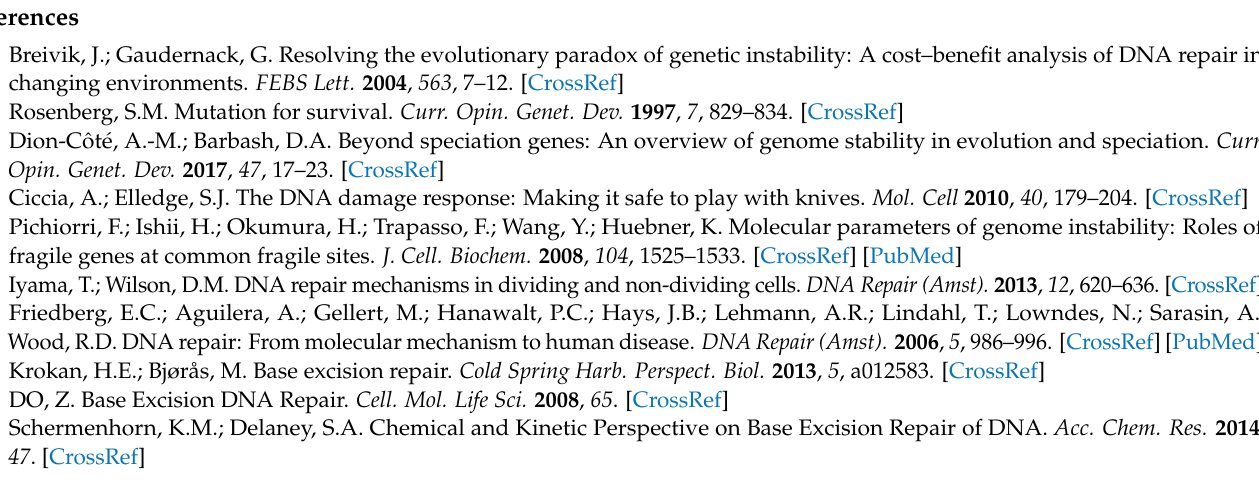
Figure S2: Temperature and chemical cell stress-related phenotypes of the C . neoformans APN -like genes’ mutants, Figure S3: Growth curve of C. neoformans WT and mutant strains, Figure S4: The apn1 ∆ , apn2 ∆ and apn1 ∆ apn2 ∆ mutants are not susceptible to oxidizing agents, Figure S5: The capsule expansion, phospholipase and urease activities were unaffected by the disruption of Apn-like genes, Figure S6: Evaluation of virulence of C. neoformans APN mutants using G. mellonella infection model, Table S1: Primers used in this study and Table S2: Strains used in this